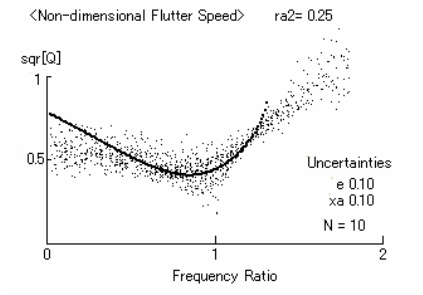
Fig 3. Boundary with uncertainty in the location of center of gravity